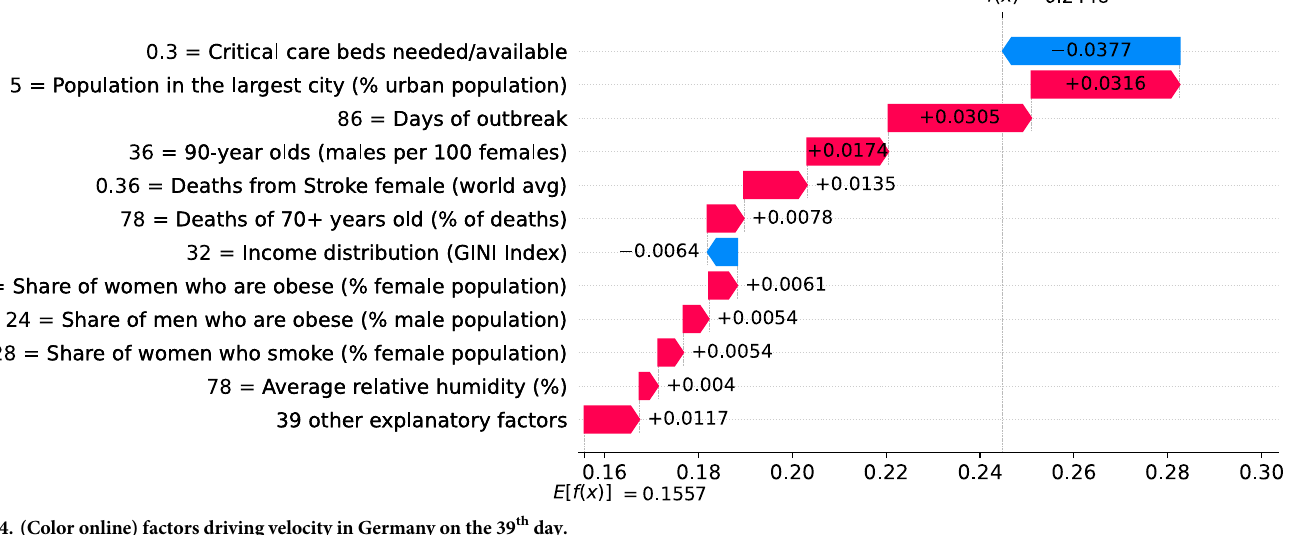
Fig 24. (Color online) factors driving velocity in Germany on the 39 th